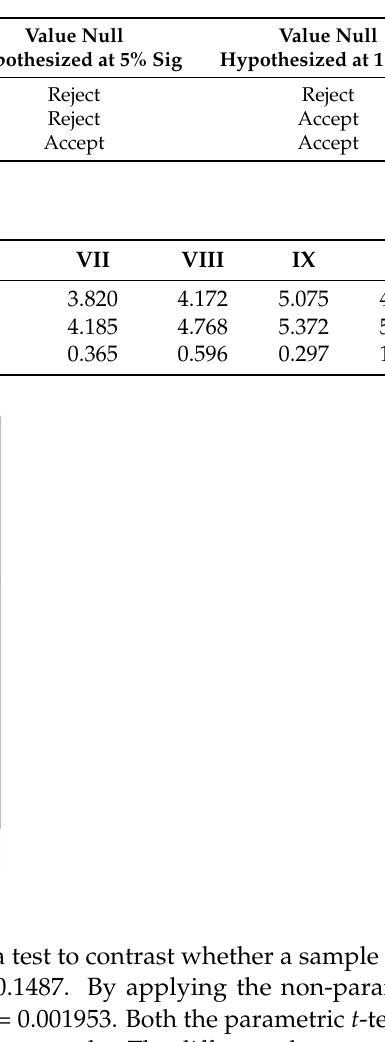
Table 5. Results (8 samples) of the Wilcoxon test for F m .